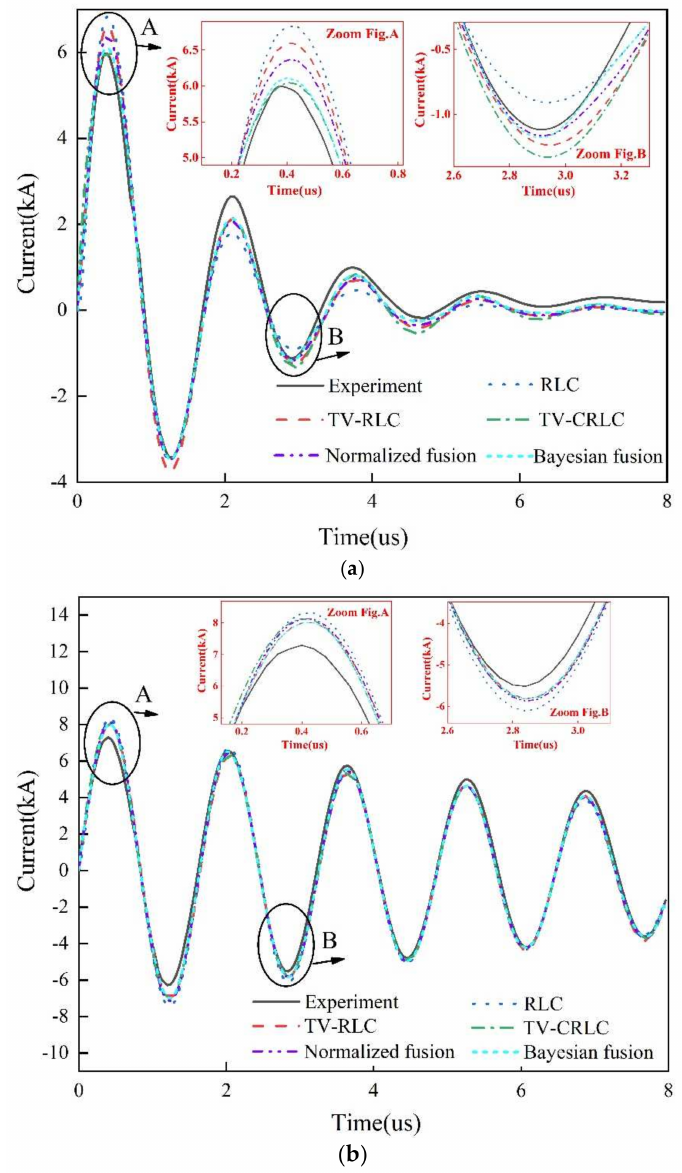
Figure 5. Comparison of current prediction curves of different circuit models and fusion models and test curves for high-voltage EPB: ( a ) red sandstone and ( b ) granite. Table 2. Relative error reduction rate of EPB current prediction of different single models and model fusion